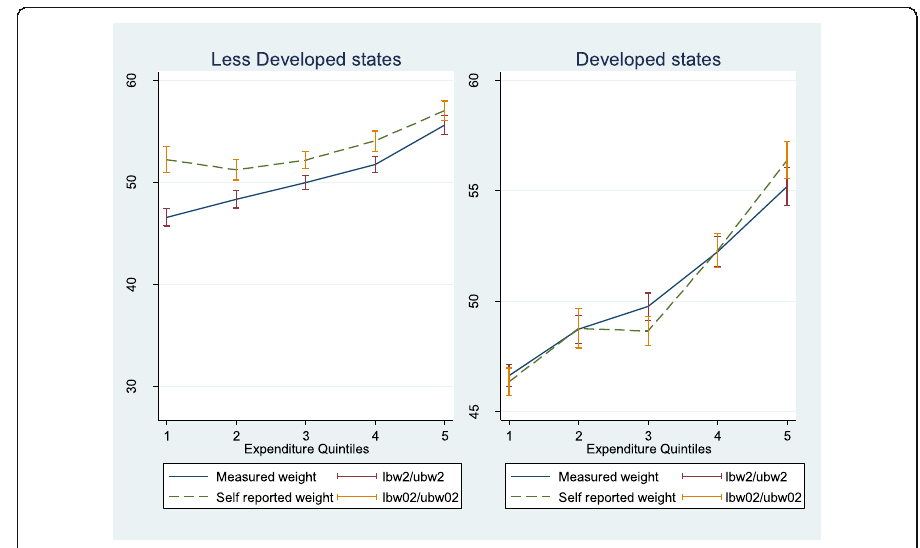
Fig. 5 Comparison of self-reported and measured weight by development level and